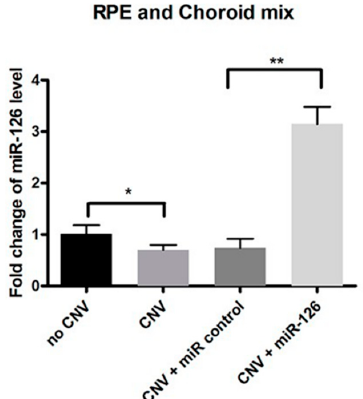
Figure 1. miR-126 expression in choroidal neovascularization (CNV) mice. Fourteen days after transfection, the expression of miR-126 in CNV mice eyes in the following treatment groups: (1) No